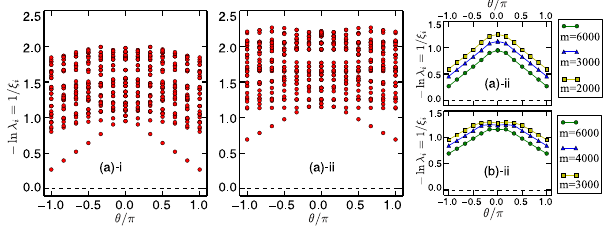
FIG. 13. (a) The singlet excitation spectrum for the (a)-i YC10- 2 and (a)-ii YC12-2 cylinders; here, J 2 ¼ 0 . 05 , and bond dimension m ¼ 6000 . (b) The dependence on the bond dimen- sion m of the lowest singlet excitation spectrum for the (b)-i YC10-2 and (b)-ii YC12-2 cylinders. The singlet excitation keeps decreasing as the bond dimension m increases.